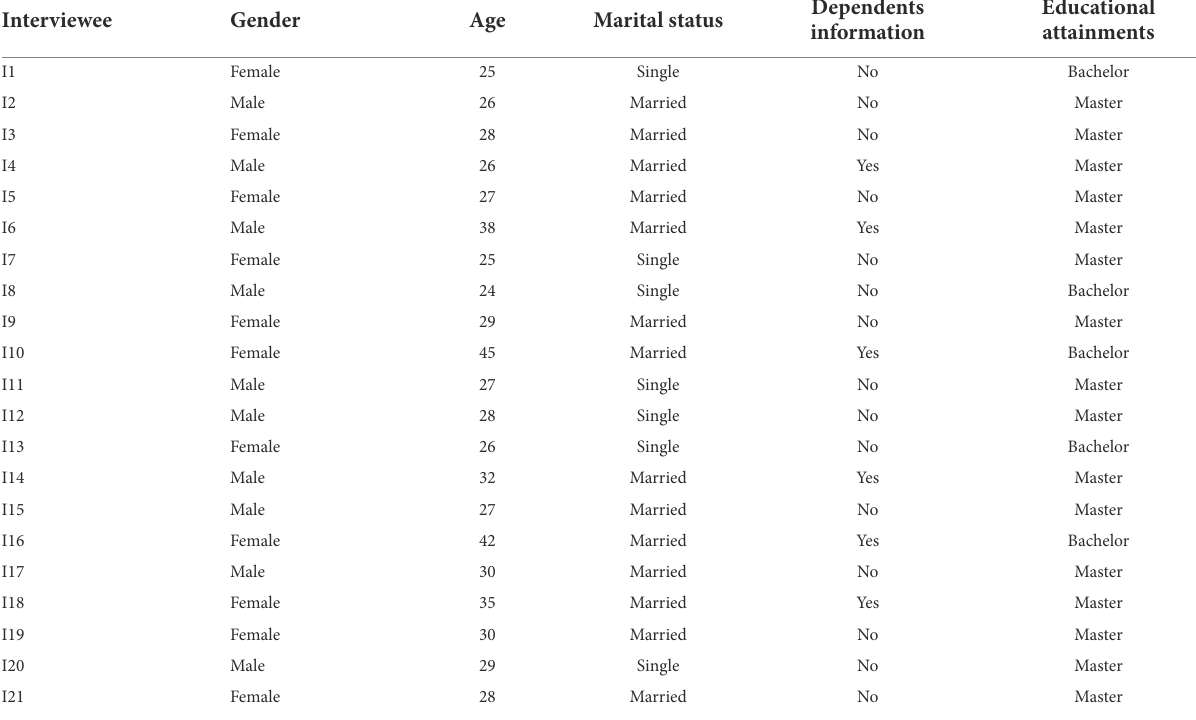
TABLE 2 Detailed information of